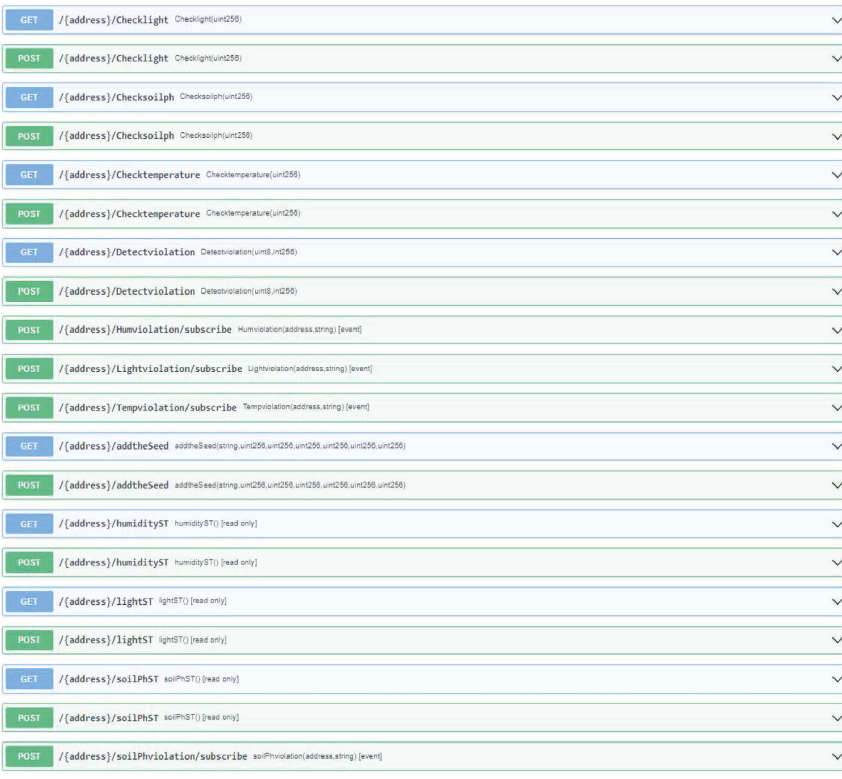
Figure 10: Some of the functionalities of the smart